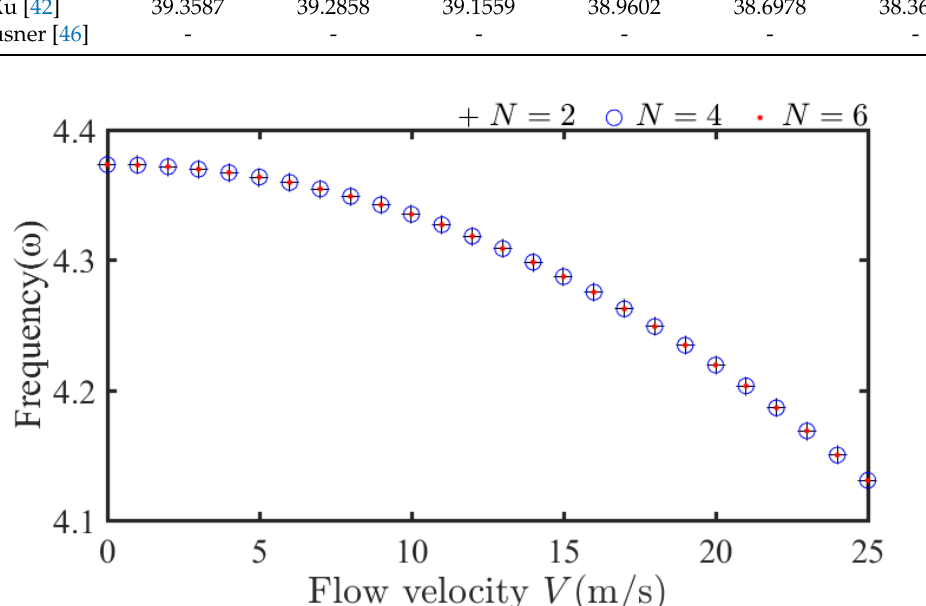
Figure 3. The fundamental variation frequency of pipes conveying fluid frequency versus flow velocity.